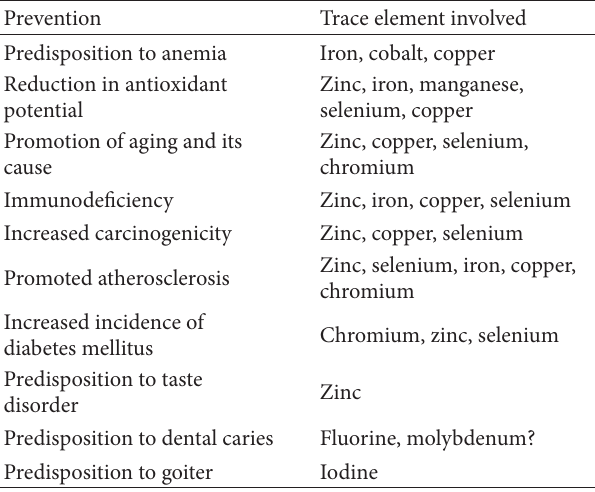
Table 2: Trace elements and preventive medicine